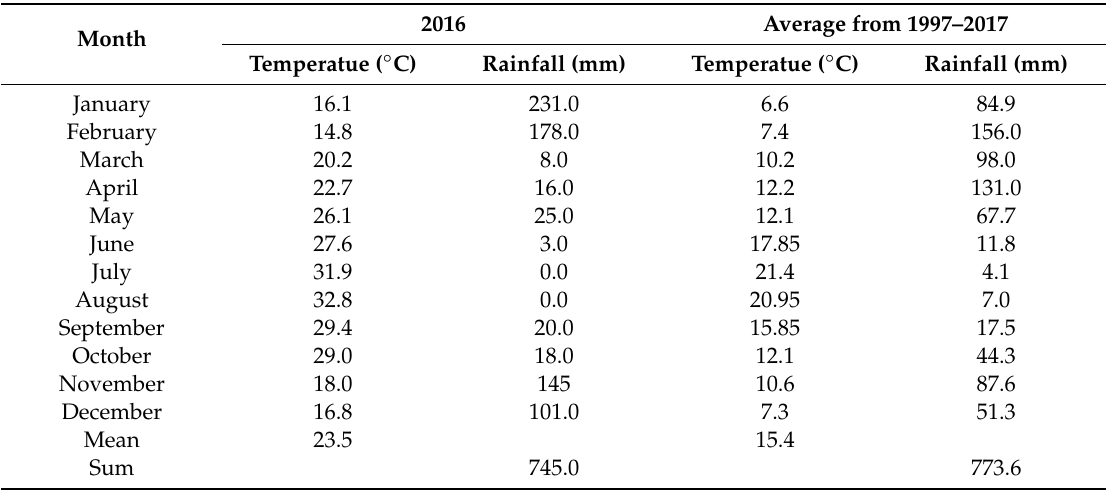
Table 1. Climatic conditions recorded in the experimental station of the Faculty of Life and Natural Sciences, University of Blida 1,